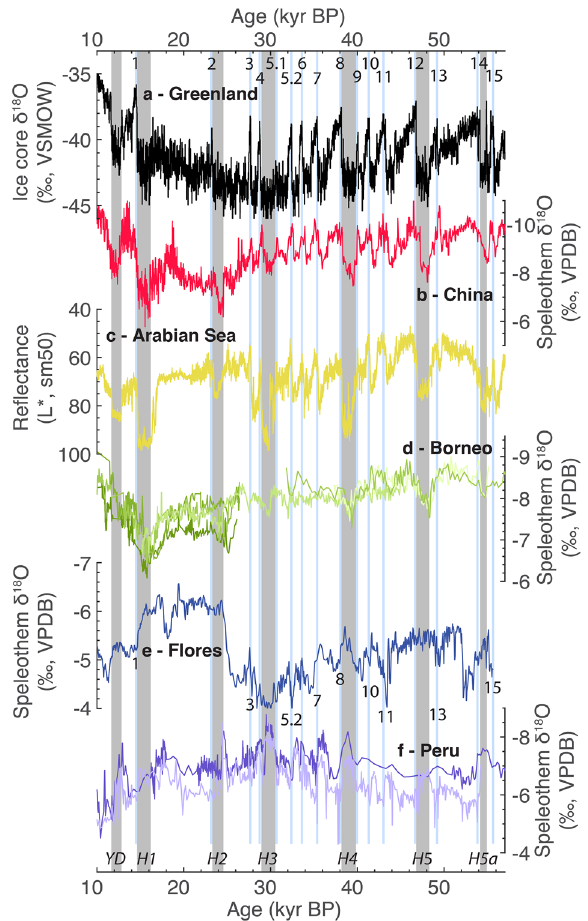
Figure 3. Millennial-scale events of the last glacial. ( a ) Greenland NGRIP ice core record on the GICC05/ INTIMATE timescale 47 . Dansgaard-Oeschger interstadials (blue bars) are numbered. ( b ) Hulu-Sanbao-Dongge speleothem composite for China 34 . ( c ) Sediment core reflectance for the Arabian Sea 42 . ( d ) Speleothem records for Gunung Mulu National Park, Borneo 44,61 , ( e ) Liang Luar speleothem composite record, adjusted for seawater δ 18 O (this study). Possible responses to Dansgaard-Oeschger interstadials are numbered. ( f ) Speleothem records for Cueva del Diamante and El Condor Cave in Peru 40 . Grey bars indicate the five canonical Heinrich events